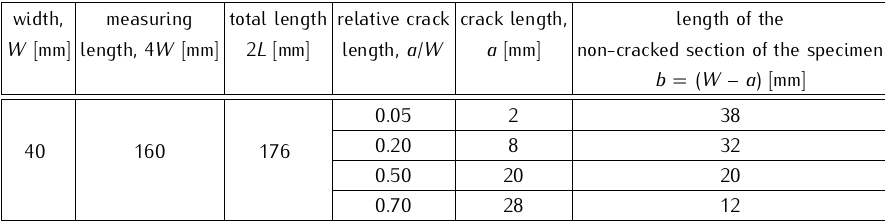
Table 2. Geometrical dimension of the CC(T) and SEN(T) specimens used in numerical analysis.